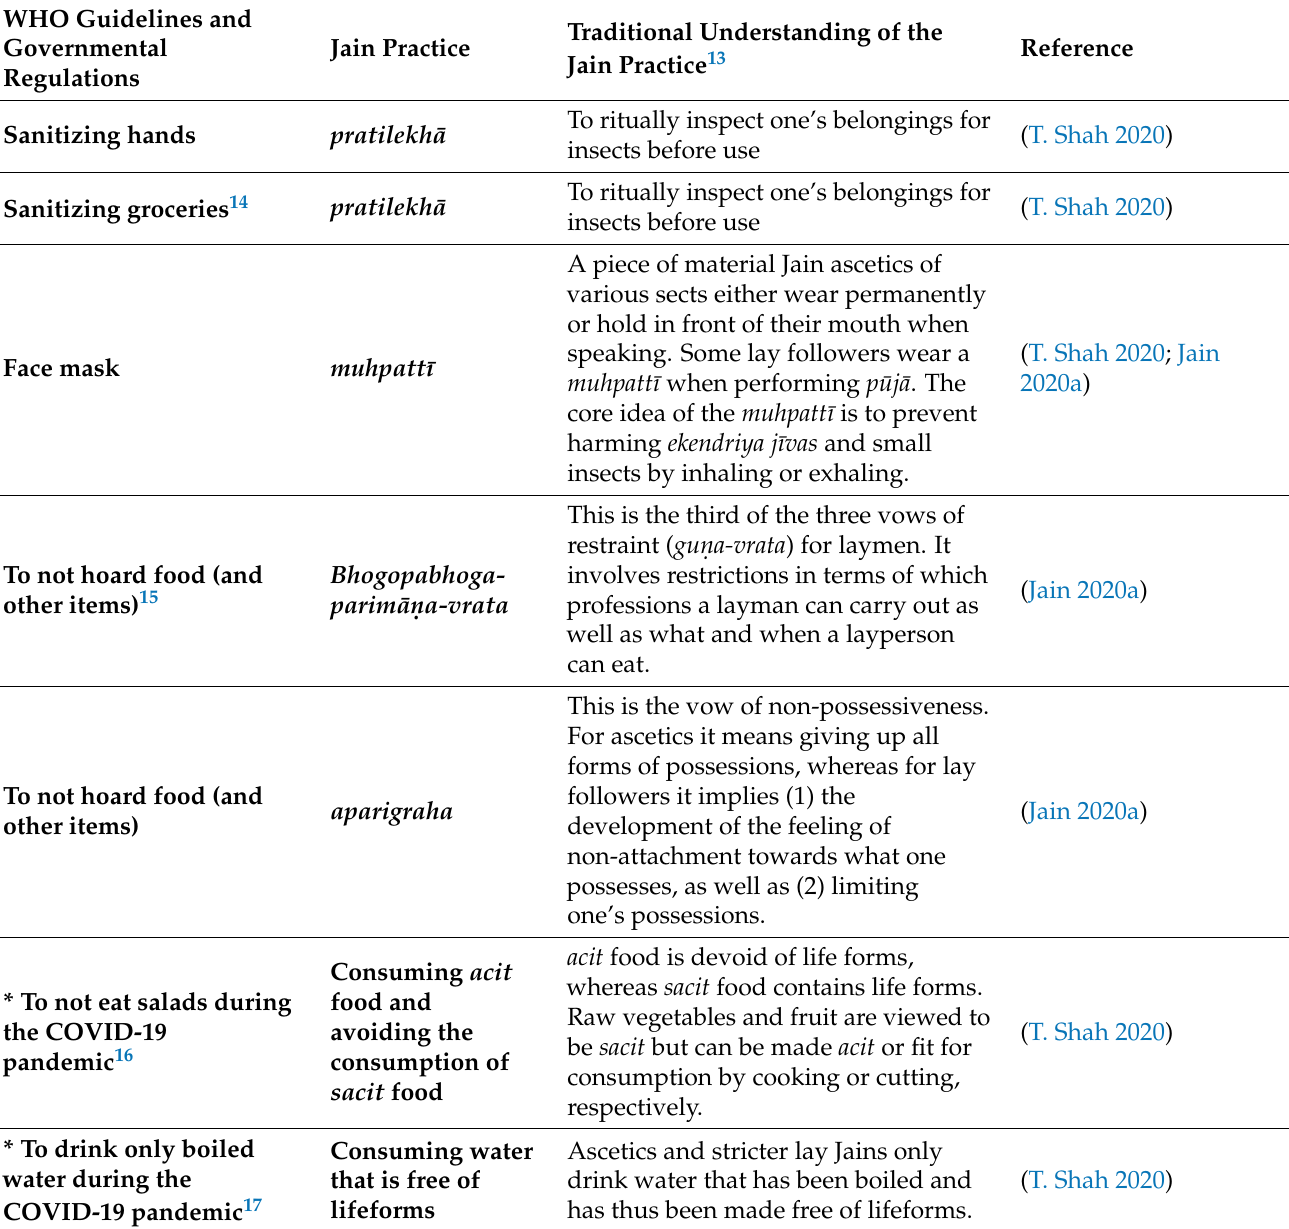
Table 1. WHO Guidelines, Governmental Regulations, and Jain Practices 12